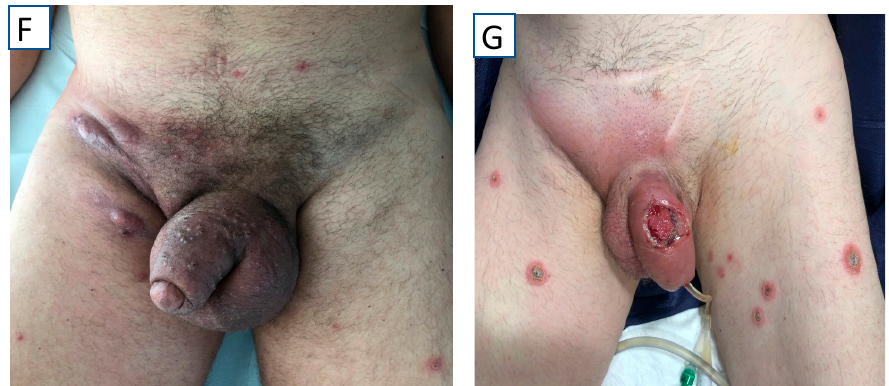
Arm; ( F ) Abdomen, genital area and thighs; ( G ) Abdomen, genital area, and thighs.